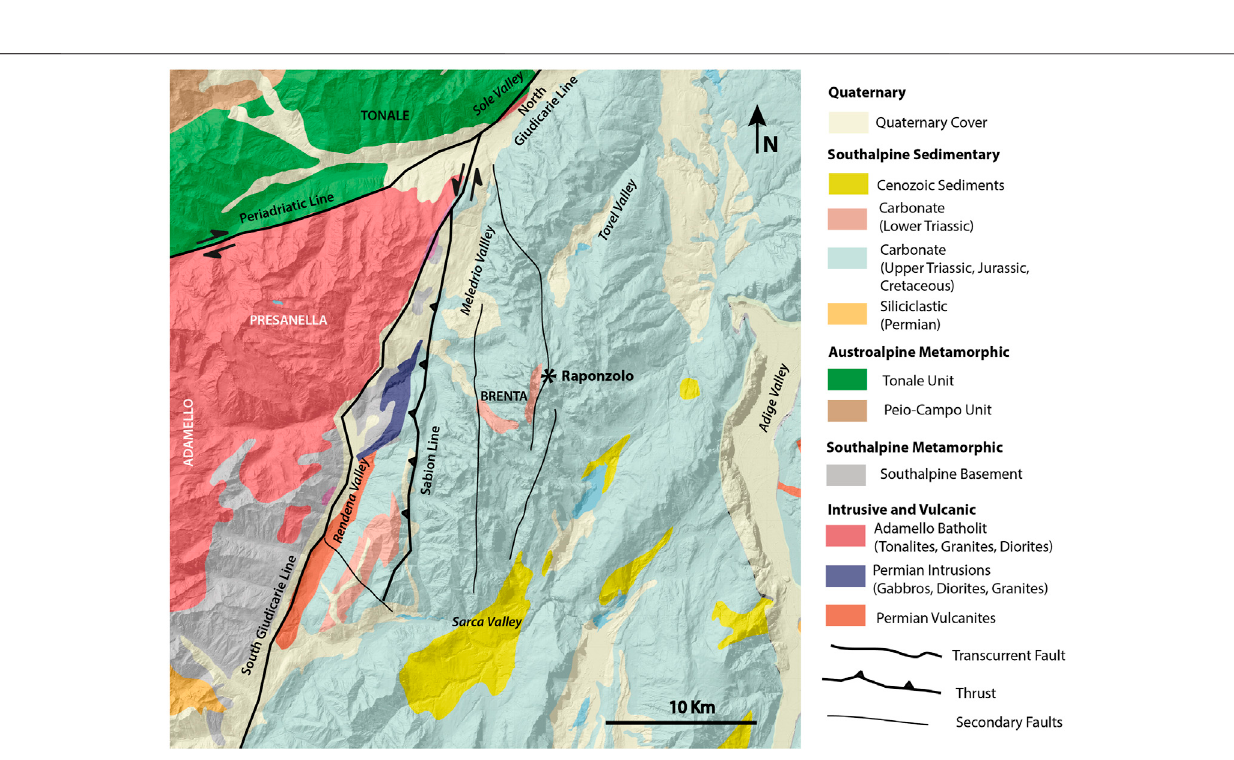
Frontiers in Earth Science |